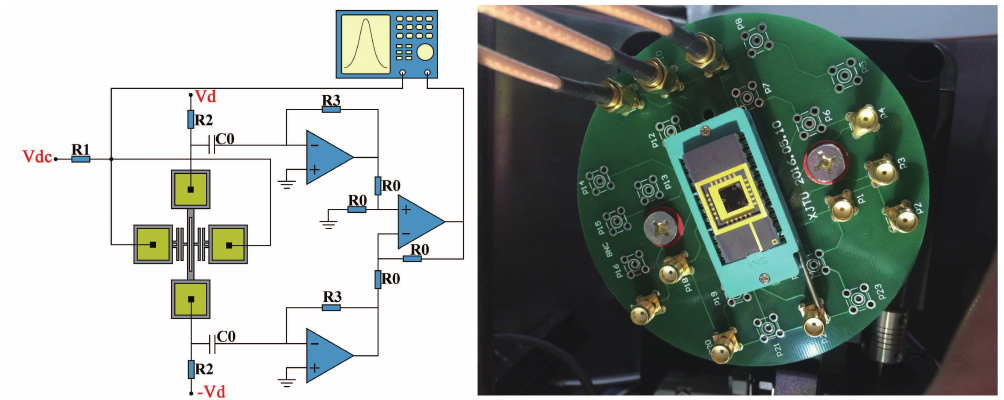
Figure 6. Schematic diagram of the open-loop test circuit ( a ) and installation ( b ).